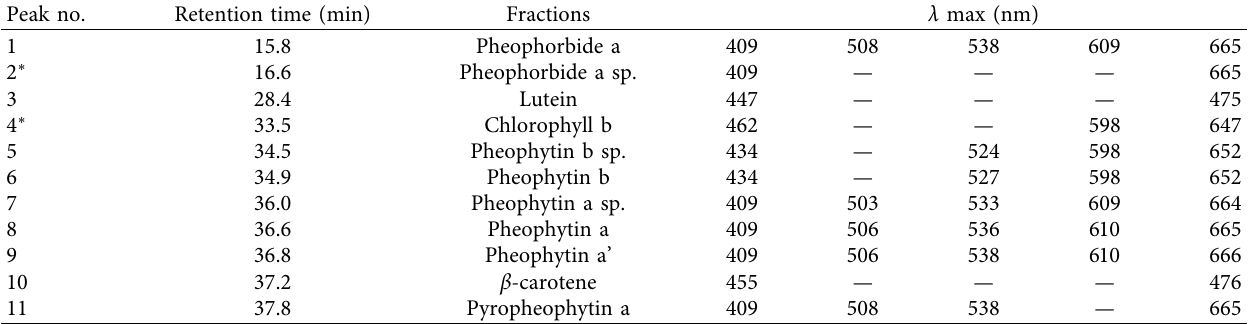
Table 1: Detection of chlorophyll and carotenoid fractions found in the pigments extracted from dregs of green and black teas. The peak numbers correspond to the identified peaks in the chromatograms of Figure 4. Peak